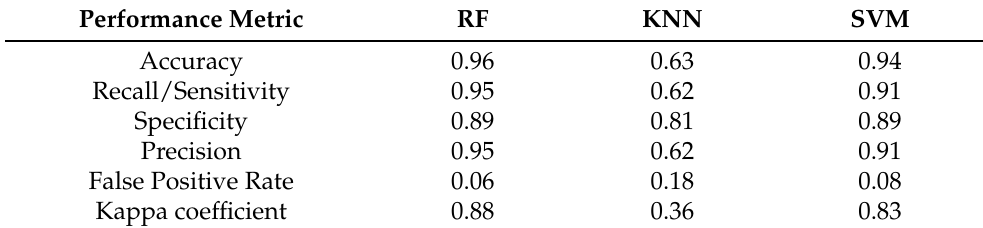
Table 3. Comparison of performance metrics for the RF classifier, KNN classifier and SVM classifier. Performance Metric